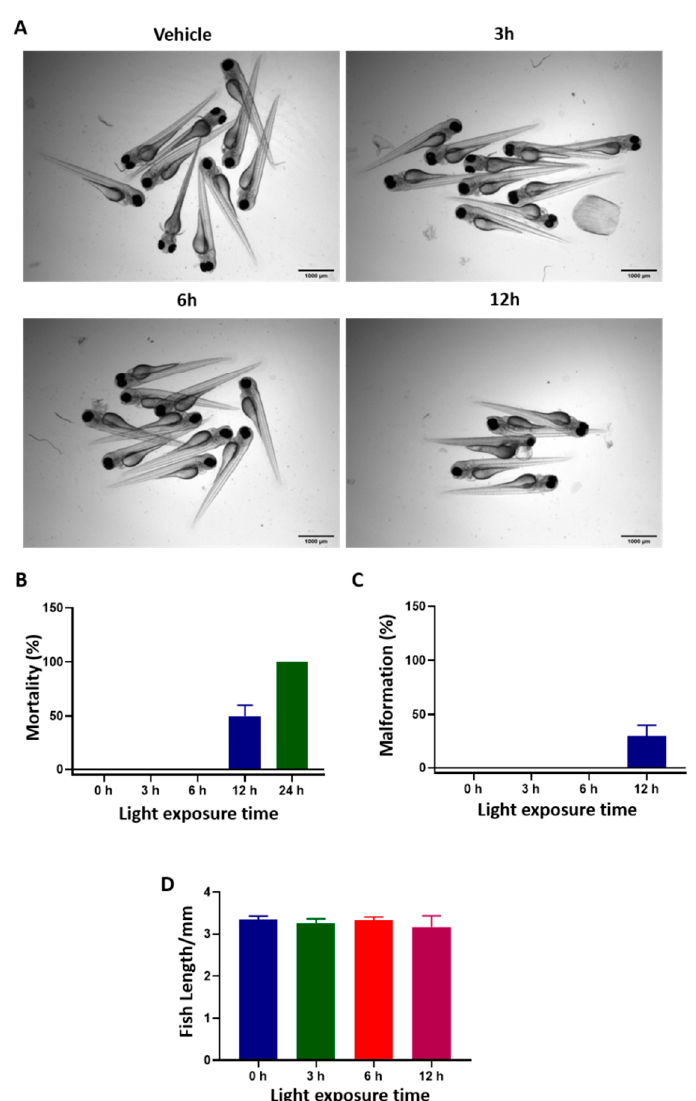
Figure 4. Light toxicity in zebrafish embryos. 2 dpf embryos ( n = 30) were exposed to green light (21 mW / cm 2 , 520 nm) for 0, 3, 6, or 12 h. ( A ) Transmitted light images of the embryos after light irradiation. ( B – D ) The percentage of mortality, malformation and fish length after various time of light exposure. Results represents the means ± SD from three independent